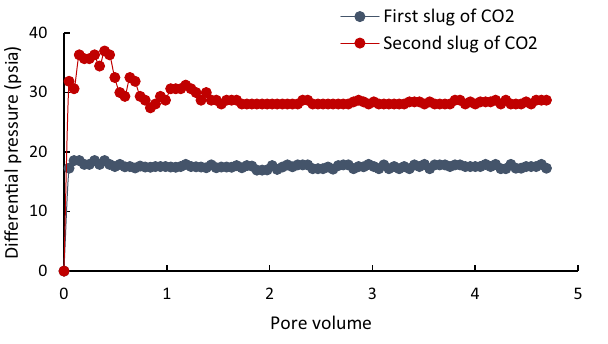
Fig. 8 Performance of injected CO factant of 0.4%IOSc 15–18